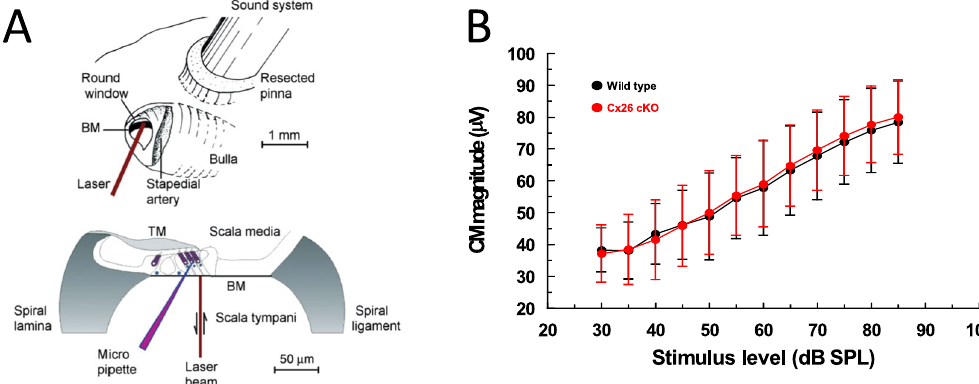
Figure 3. Round window CM are similar in WT and Cx26 cKO mice. ( A ) Techniques used to make electrophysiological and mechanical measurements from the cochlea (modified with permission 23, 24 ). ( B ) CM magnitude as function of stimulus level for stimulation with 5 kHz tones (mean ± standard deviation, n = 5). Measurements from mice, 21–26 days